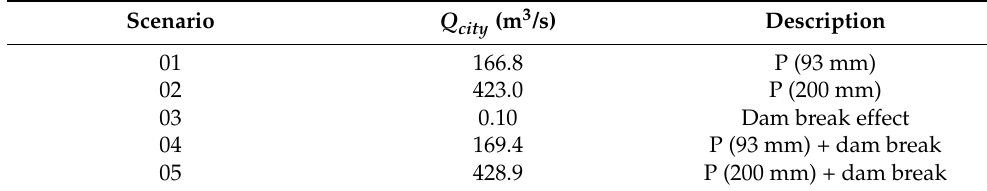
Table 4. Summary of the max discharge values from the HEC-HMS simulation. Scenario Q city (m 3 /s) Description 01